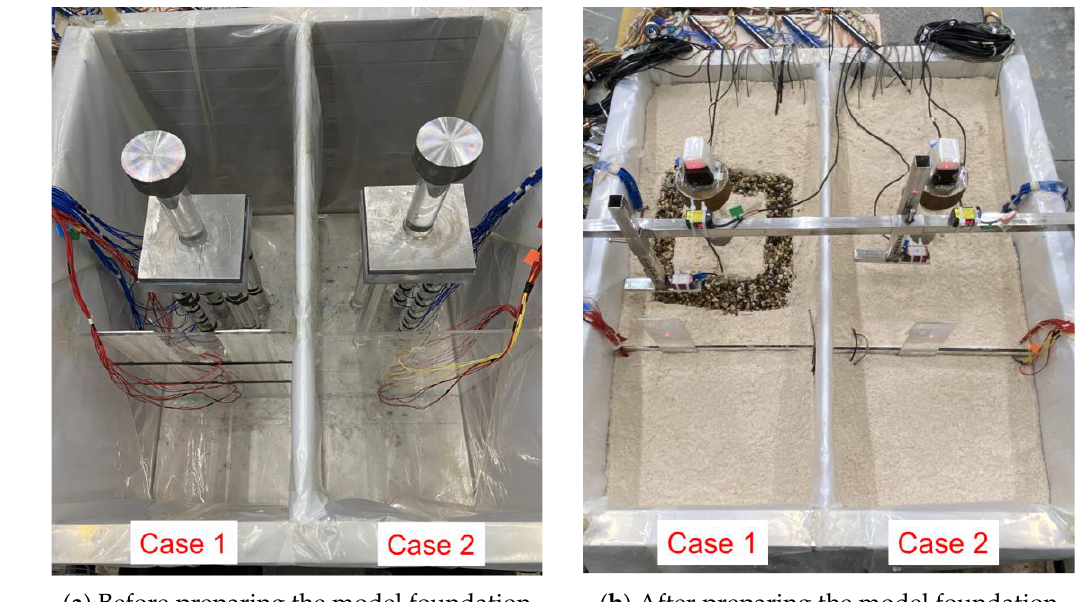
Figure 3. Annotated photograph of the model foundation.